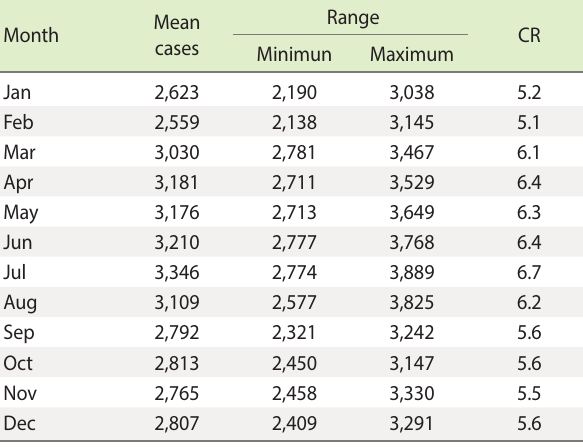
Table 3. Monthly mean number and crude rate (CR) of tuberculosis notifications, 2006-2016